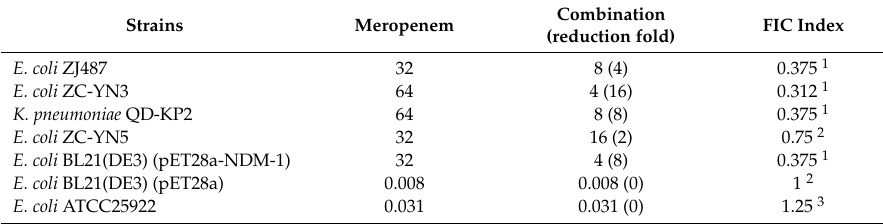
Table 2. Minimal Inhibit Concentration (MIC) and Fractional Inhibition Concentration (FIC) values of meropenem alone and in combination for the tested bacterial strains.